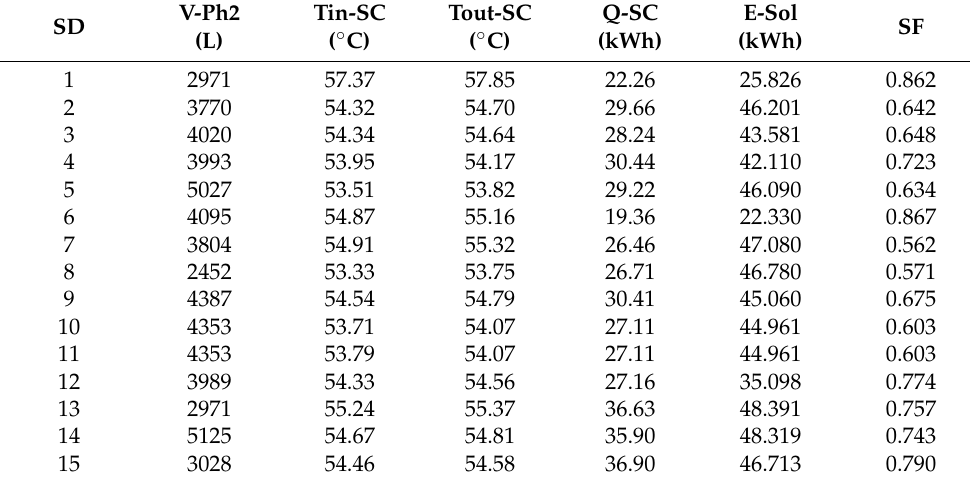
Table 4. Performance of solar collectors in the hybrid DX-SAHP water heater during the second phase of its operation. V-Ph2 Tin-SC SD (L) ( ◦ C)